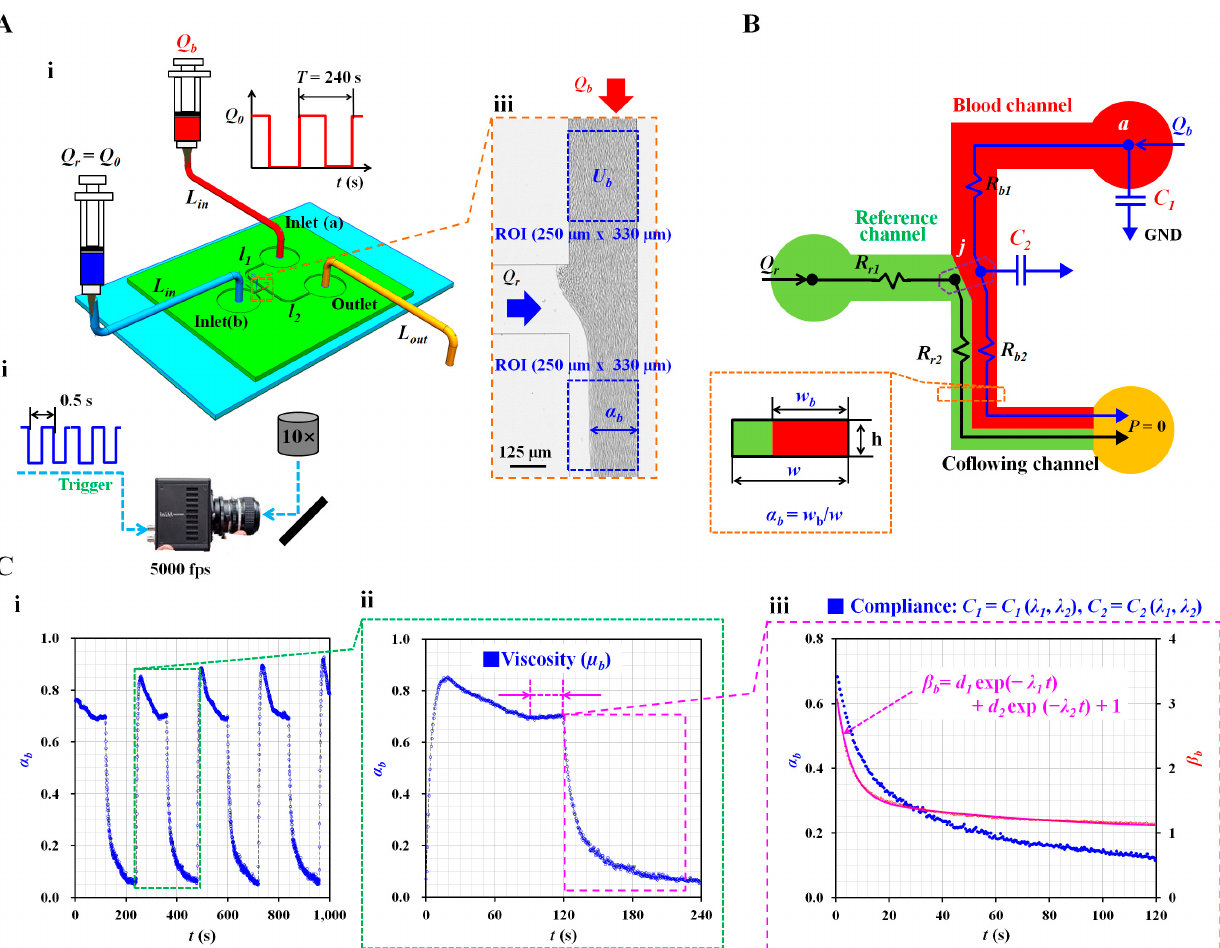
Figure 1. Proposed method for measurement of blood viscoelasticity under microcapillary blood flow. ( A ) Schematic diagram of experimental setup, including a microfluidic device, two syringe pumps, and image acquisition system. ( i ) Microfluidic device consisting of two inlets (a, b), an outlet, and microfluidic channels (i.e., reference channel, blood channel, and coflowing channel). Using two syringe pumps, blood flow rate ( Q b ) set to a periodic on/off profile (i.e., amplitude: Q 0 , and period: T ). Flow rate of reference fluid set to a constant flow rate (i.e., Q r = Q 0 ). The corresponding length of each polyethylene tubing is denoted as L in (for inlet tubing) and L out (for outlet tubing). ( ii ) Image acquisition system for capturing blood flow in the microfluidic channels. With high-speed camera set to 5000 fps, microscopic images are sequentially captured at an interval of 0.5 s. ( iii ) Microscopic image showing interface ( α b ) in the coflowing channel and blood velocity ( U b ) in the blood channel. ( B ) Mathematical representation with discrete fluidic circuit elements for estimating viscoelasticity. The microfluidic system (i.e., two fluids, flexible microfluidic device, and polyethylene tubing) is modeled as discrete fluidic elements, including flow rate ( Q r and Q b ), fluidic resistance ( R r 1 , R r 2 , R b 1 , and R b 2 ), and compliance ( C 1 and C 2 ). Here, ‘ (cid:73) ’ denotes the zero value of pressure ( P = 0). ( C ) As a preliminary demonstration, control blood (Hct = 50%) was prepared by adding normal RBCs to autologous plasma, with flow rate of blood set to on/off pattern (i.e., Q 0 = 1 mL/h, T = 240 s), and flow rate of reference fluid set to Q r = 1 mL/h. ( i ) Temporal variations of α b for up to 1000 s. ( ii ) Quantification of blood viscosity using steady variations